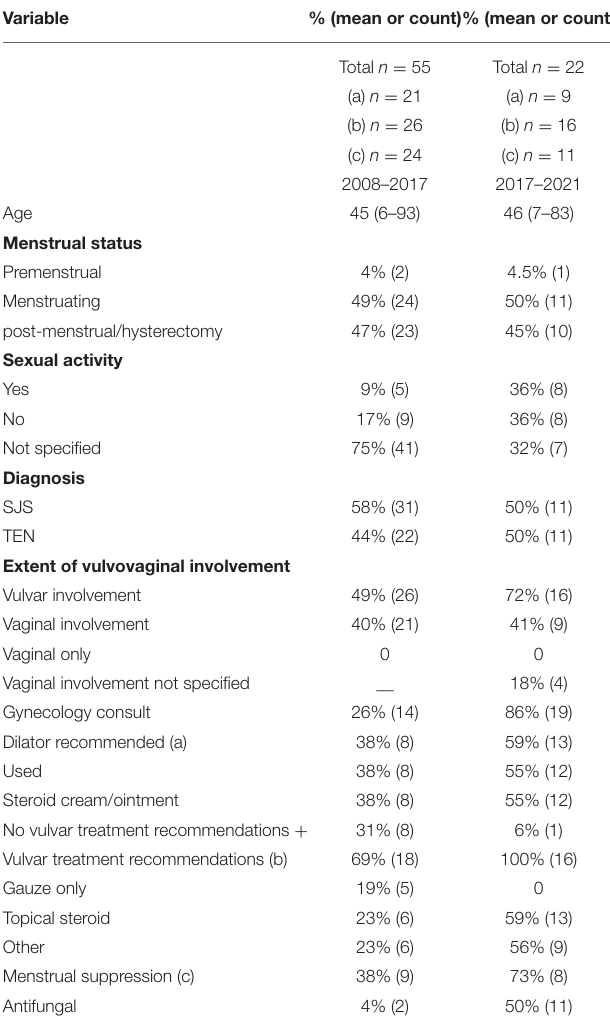
TABLE 1 | Demographics and clinical variables of patients with SJS/TEN from 2008 to 2021.